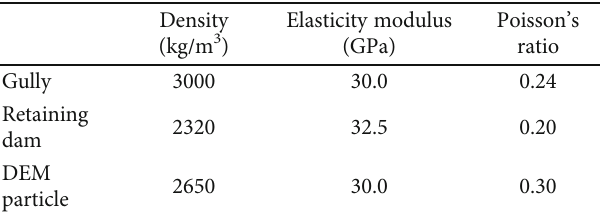
Figure 4: Image map and fl oor plan of Nanjiaogou small watershed. Table 1: Basic parameters for